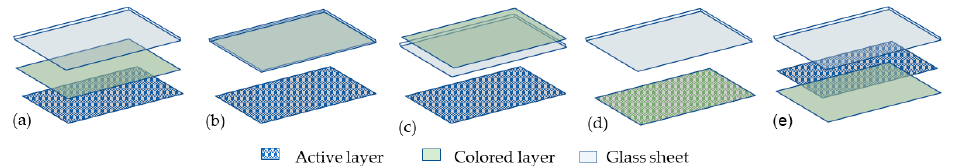
Figure 2. Relative position of the coloured layer in the BIPV module assembly: ( a ) coloured interlayer or encapsulant; ( b ) coloured coated front glass; ( c ) coloured layer on top of the front glass; ( d ) coloured or coated active layer; ( e ) coloured back sheet. Table 1. Existing colouring technique for modulating the aesthetic of BIPV modules. Coloured Layer Position Colouring Technique Technology Colour Layer Typology